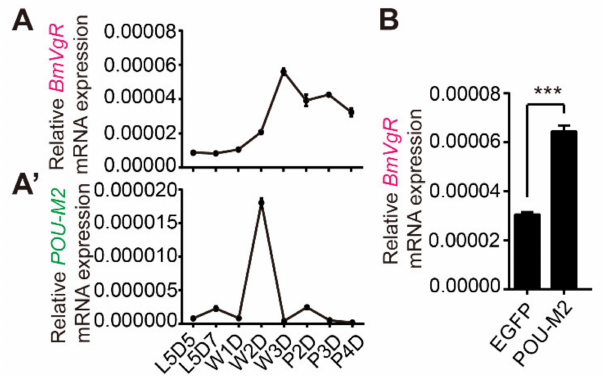
Figure 2. POU-M2 enhances the transcription of BmVgR in vitro . ( A ) and ( A’ ): Correlation analysis of POU-M2 and BmVgR expression, which is relative to the expression of the eukaryotic translation initiation factor 4A gene ( BmTIF4A ). Expression patterns of BmVgR ( A ) and POU-M2 ( A’ ) in the ovary at di ff erent stages. L5D5 / 7, day 5 / 7 of the 5th larval instar; W1D / W2D / W3D, days 1 / 2 / 3 of wandering; P2D / P3D / P4D, pupal days 2 / 3 / 4. ( B ): E ff ect of overexpression of POU-M2 on endogenous BmVgR expression in BmNs cells. The asterisks (***) represent significant di ff erences ( p < 0.001) detected using two-tailed Student’s t tests. Error bars indicate SEM ranges ( n =